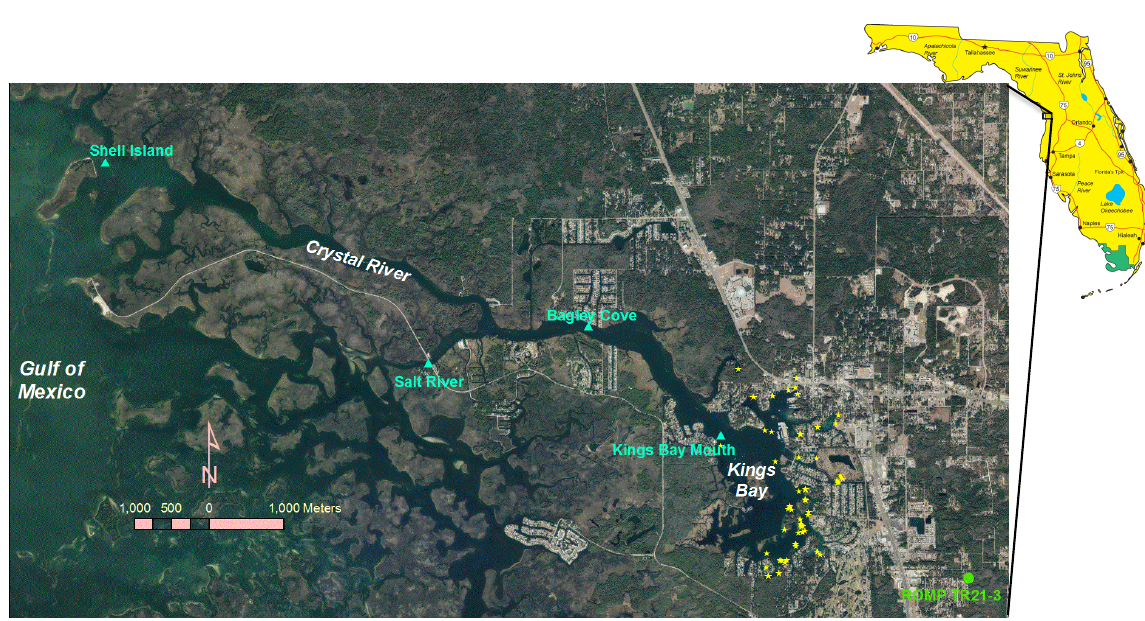
Figure 1. An aerial photo of the Crystal River/Kings Bay system located on the southwest coast of the Florida peninsula. Locations of USGS in-situ measurement stations are marked with triangles and locations of identified spring vents are marked with asterisks. The solid circle at the bottom right is the location of a well called ROMP